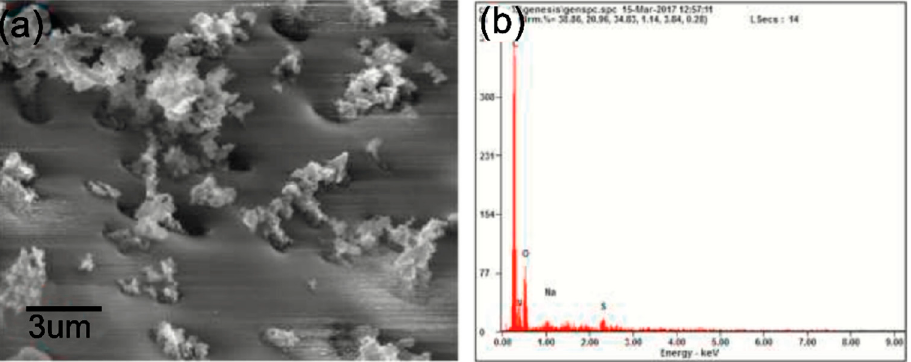
Figure 10. SEM analysis of EB-PPy-BSA hybrid structure ( a ) micrograph, and ( b ) EDS spectrum. Modified with permission from [129]. Copyright 2018 Elsevier B.V.